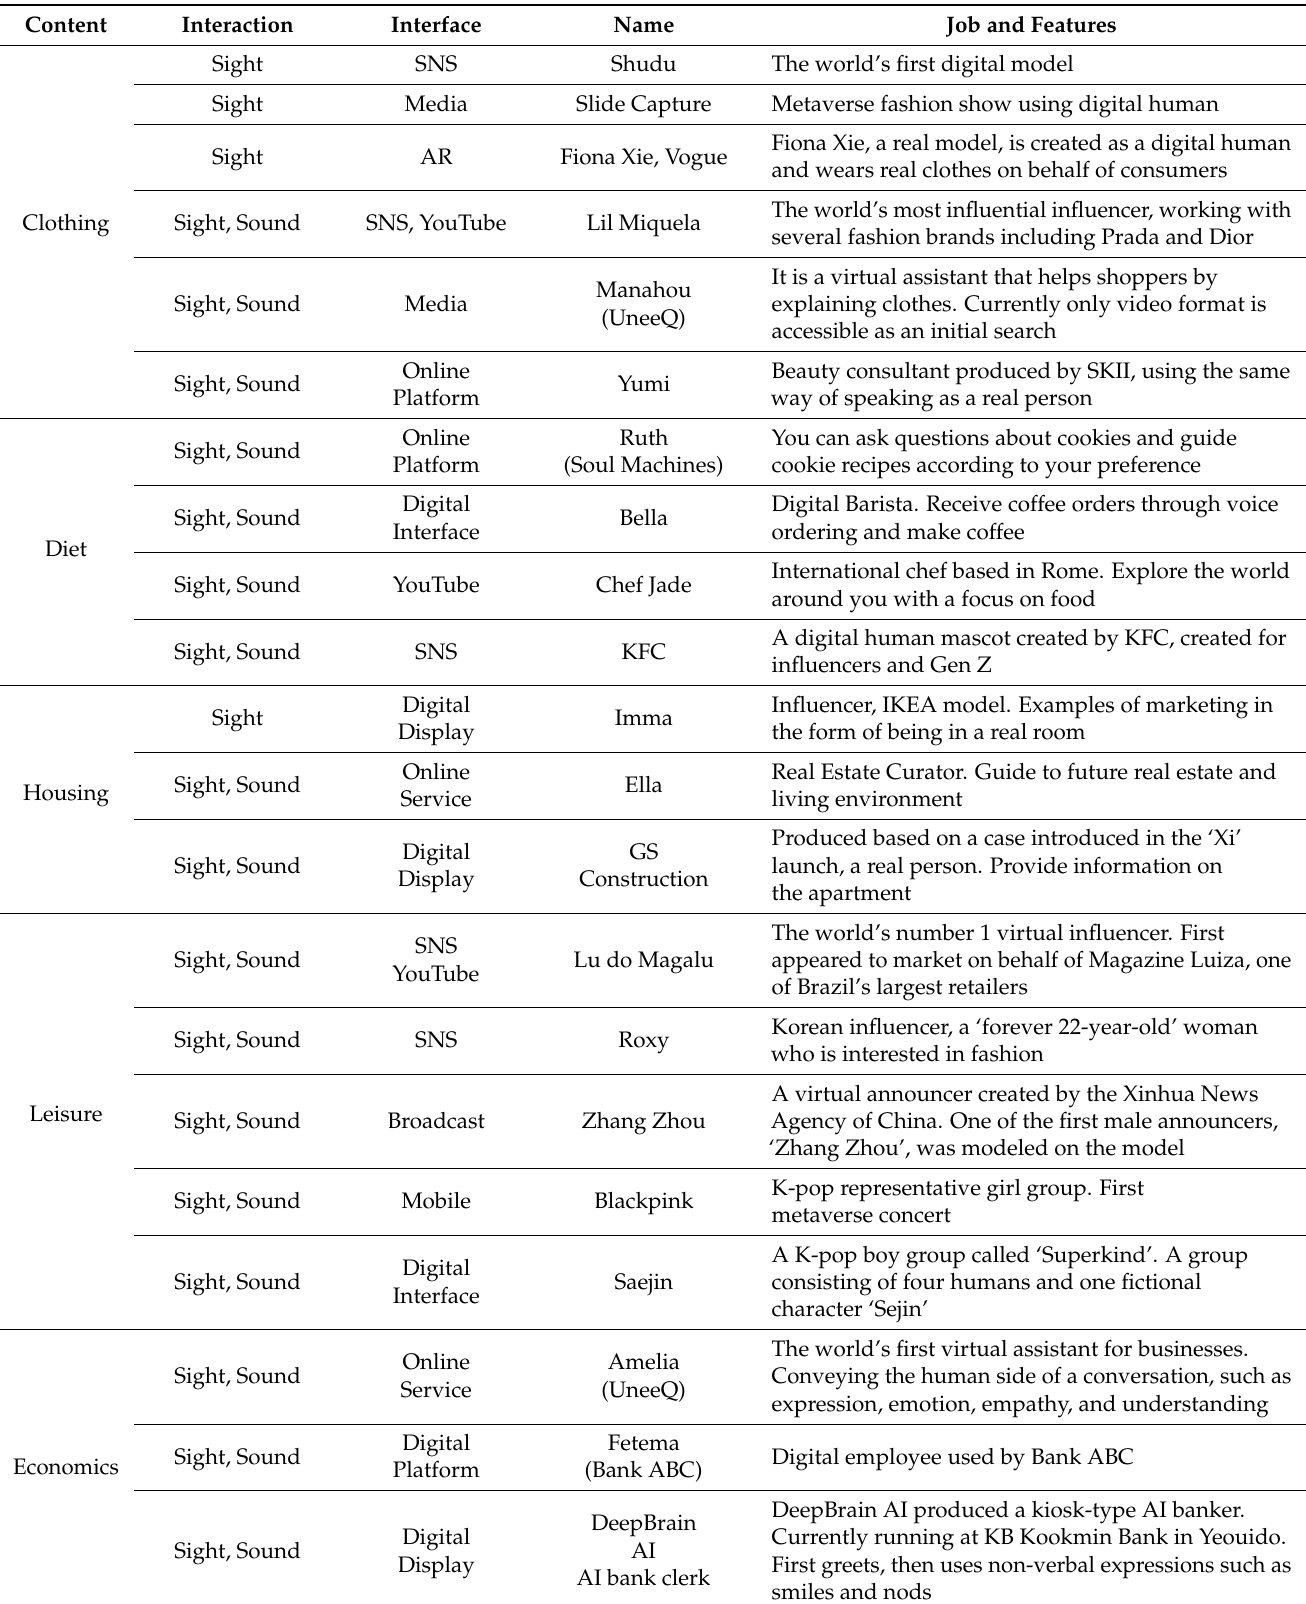
Table 3. Cases of digital humans in terms of lifestyle